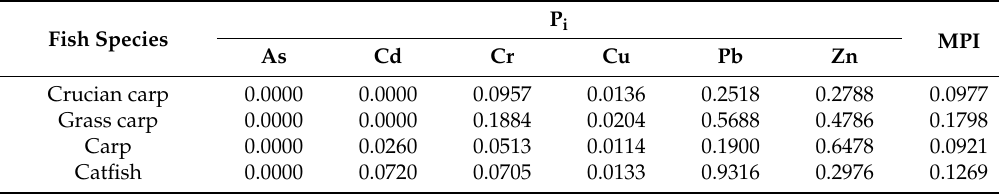
Table 1. Single and multi factor pollution indexes of trace elements in cultured fish